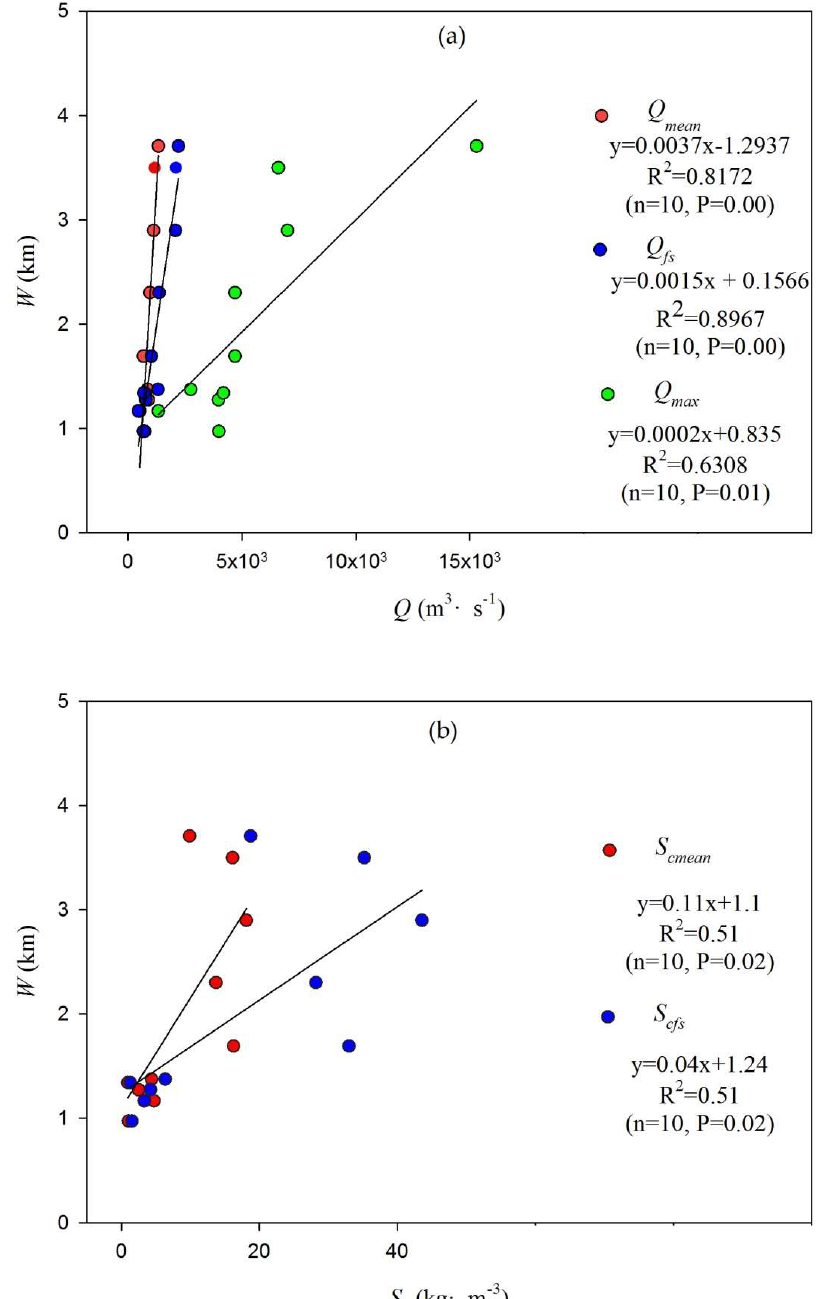
Figure 15. Relationships of wandering belt width ( W ) with flow discharge ( Q ) and suspended sediment concentration of flow ( S c ): ( a ) Q mean is the annual mean flow discharge (m 3 ·s −1 ), Q fs is the annual mean flow discharge in the flood season (m 3 ·s −1 ) and Q max is the annual maximum flow discharge (m 3 ·s −1 ); and ( b ) S cmean is the annual suspended sediment concentration of flow (kg·m −3 ), and S cfs is the annual mean suspended sediment concentration of flow in the flood season (kg·m −3 ). Table 3. Regression equations between morphological indices and water-sediment factors.